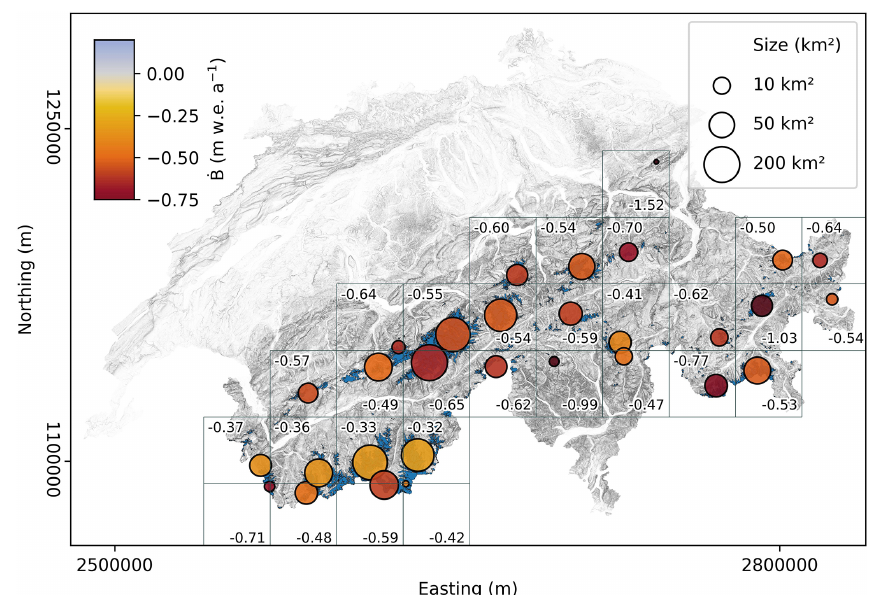
Figure 7. Area-weighted geodetic mass balance rates (colours and numbers) for 30km × 30km tiles (grey squares). The location of each circle is the average glacier centroid weighted by area in the tile, and their sizes indicate the glacier area in ca.